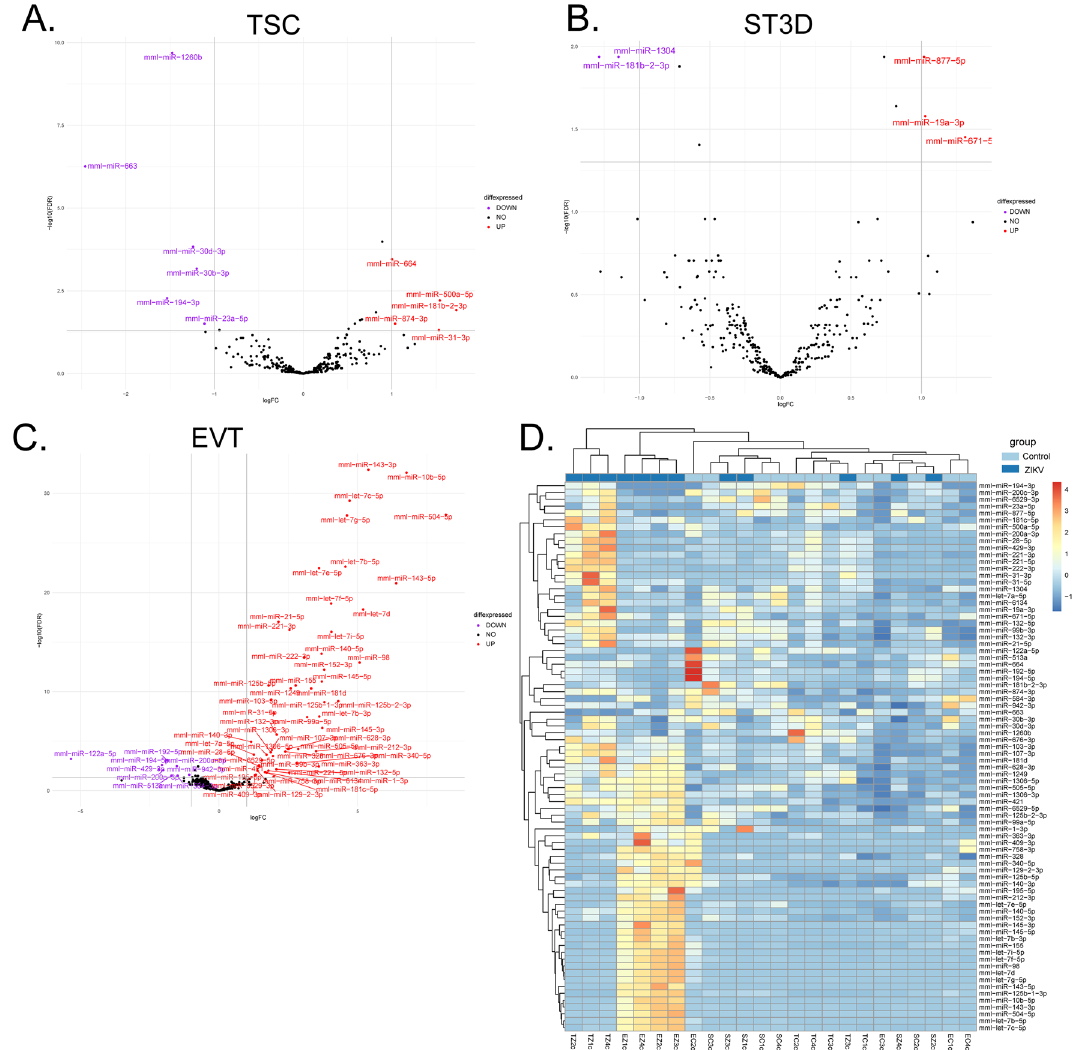
Figure 3. The impact of ZIKV exposure on the cellular miRNAome. Volcano plots of miRNA expression across for ( A ) TSC, ( B ) ST3D, and ( C ) EVT cells. Significantly differentially expressed miRNAs are displayed in color in the volcano plots for TSCs and EVTs (Purple indicates a decrease in ZIKV samples; Red indicates an increase; Black indicates no significant change). ( D ) A heatmap of all significantly differentially expressed miRNAs detected across the cell